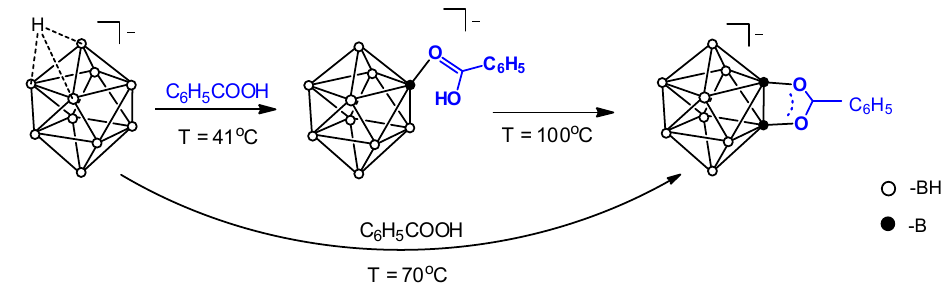
Figure 1. X-ray Structure of [B 10 H 8 O 2 CC 6 H 5 ] − anion. Length units—Å.